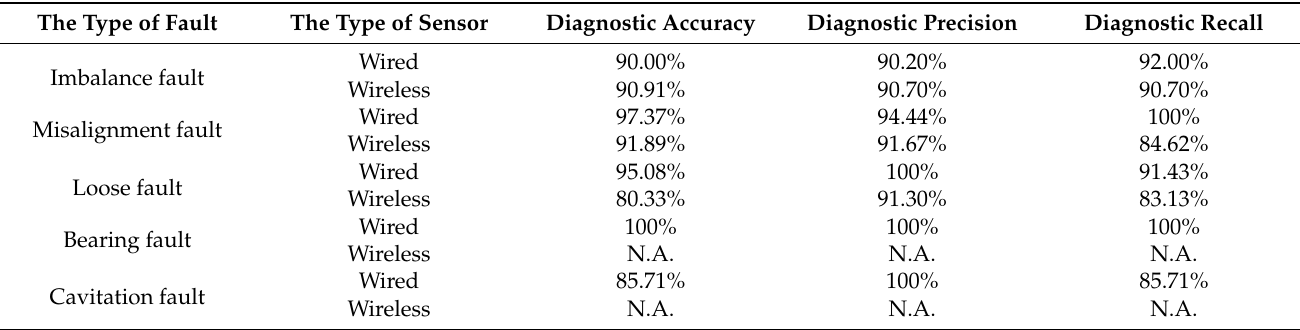
Table 7. Experimental test